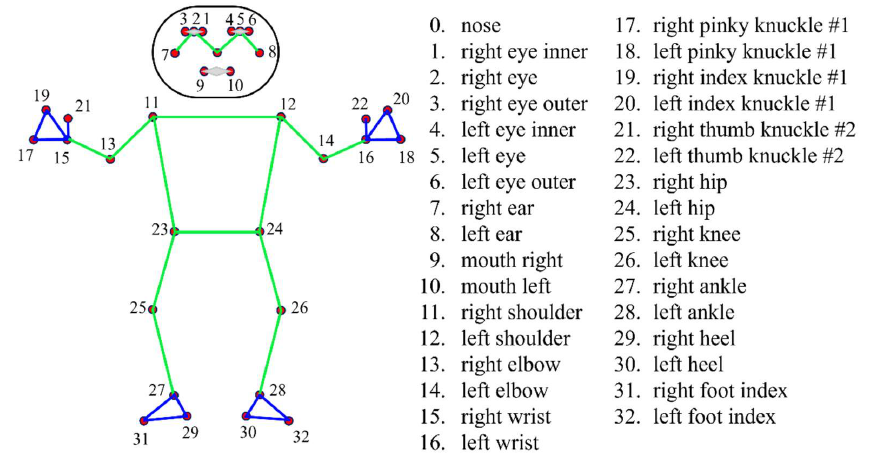
Figure 7. MediaPipe Pose Landmark.